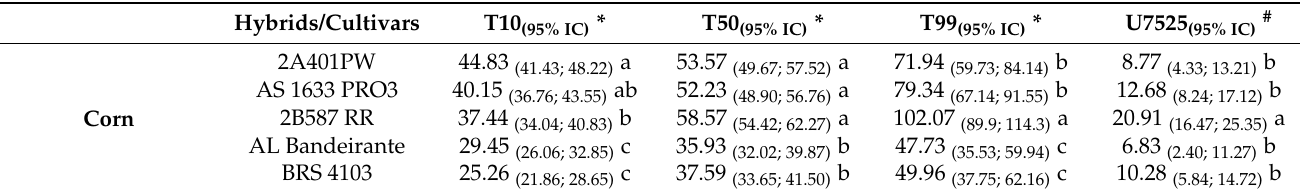
Table 6. Germination times and uniformity for corn and soybean hybrids and/or cultivars.